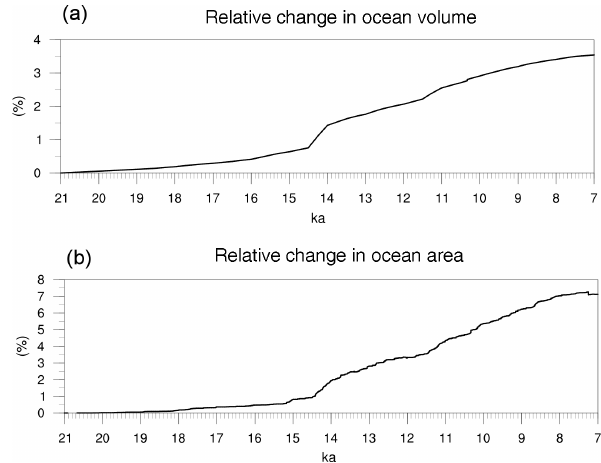
Figure 7. Time series of relative change (%) with respect to the initial value for the computed yearly mean of (a) ocean volume; and (b) ocean surface area during the test run with